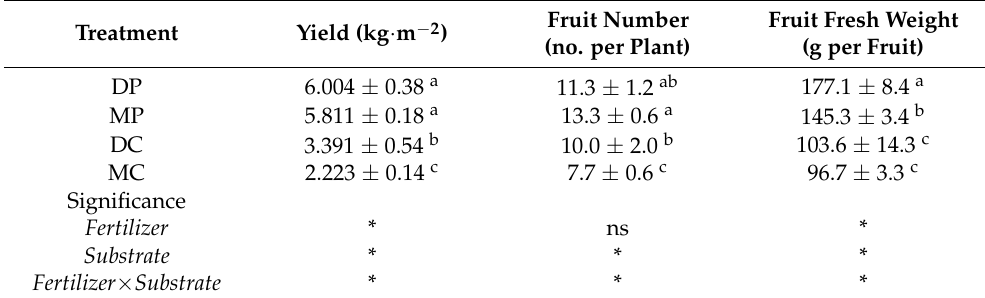
Table 4. Effects of digested pig slurry on fruit yield, ripe fruit number of per plant and single fruit fresh